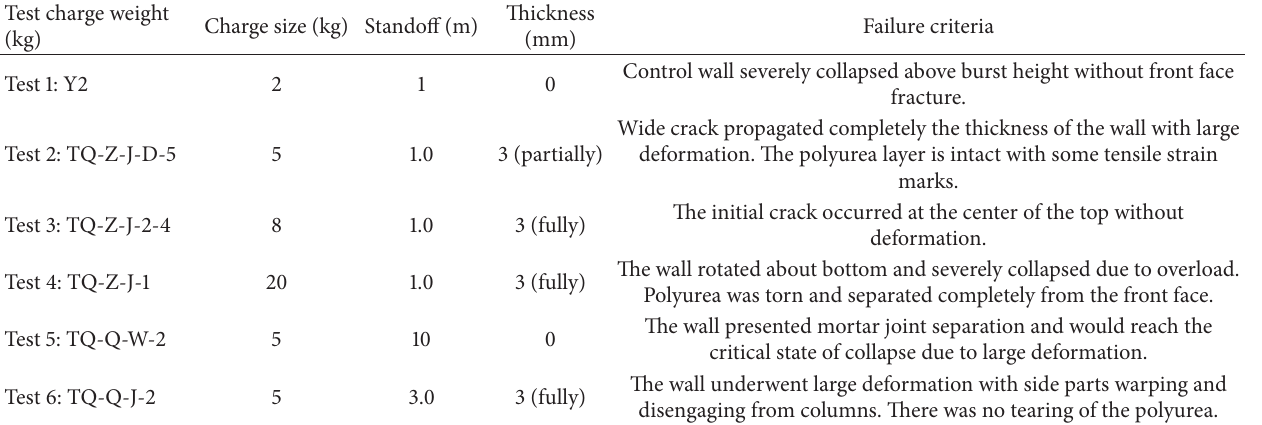
Table 2: Failure criteria